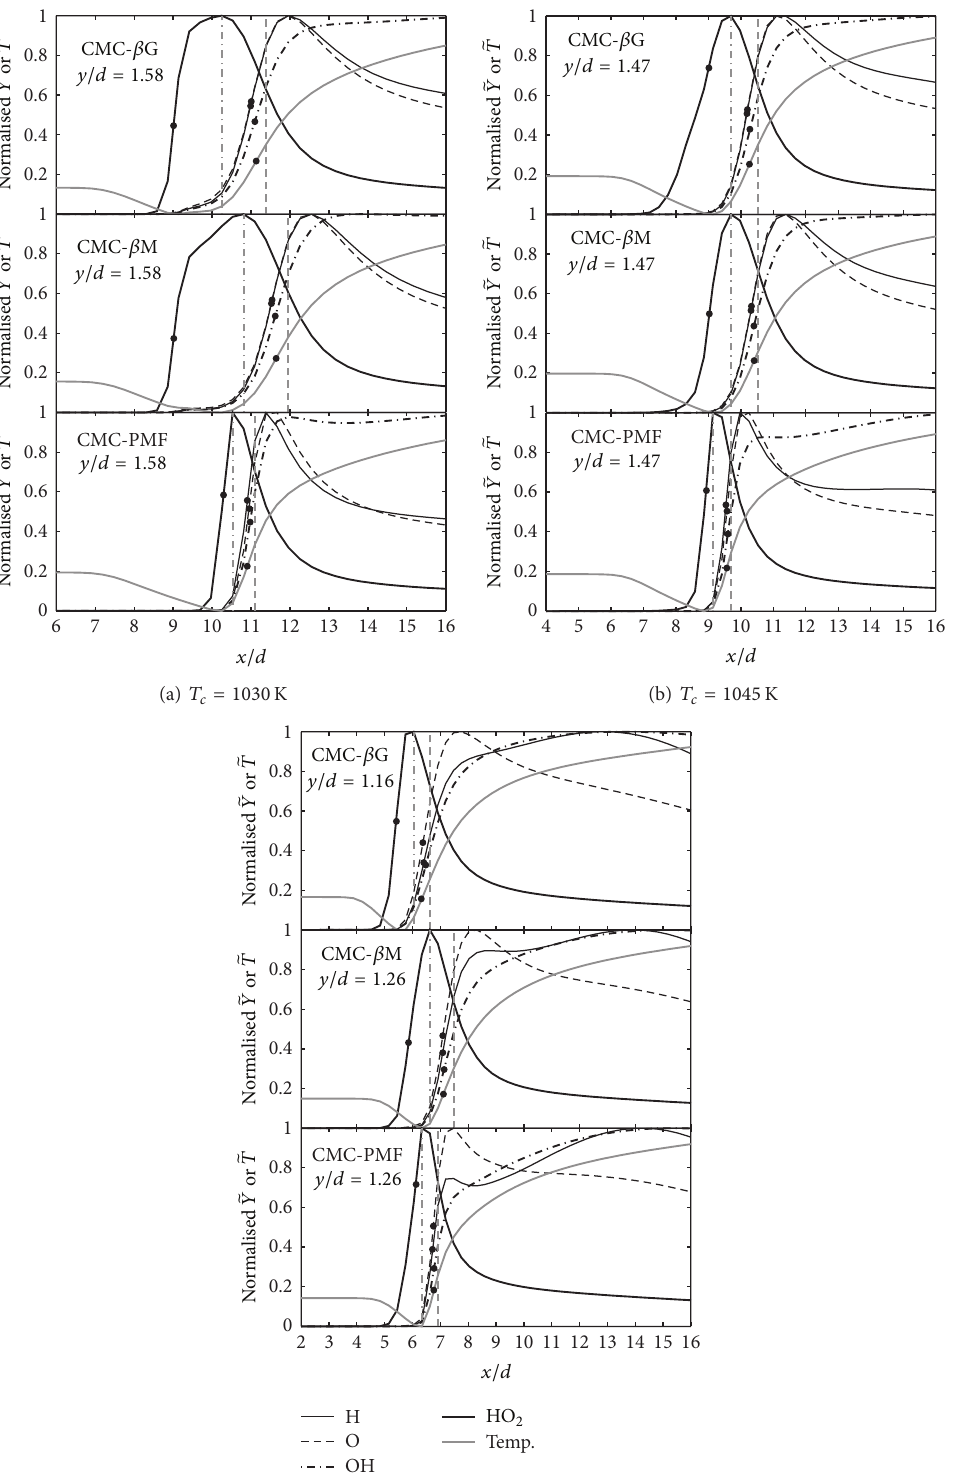
Figure 8: Axial profiles of the normalised Favre-averaged temperature and mass fractions of H, O, OH, and HO CMC realisations: (a) 𝑇 𝑐 = 1030 K, (b) 𝑇 𝑐 = 1045 K, and (c) 𝑇 𝑐 = 1060 K. The bottom, middle, and top panes correspond to CMC- 𝛽 G, CMC- 𝛽 M, and CMC-PMF, respectively. The indicated 𝑦/𝑑 values correspond to the radial locations of stabilisation. The vertical dash-dotted and dashed lines correspond to the axial locations of maximum HO maximum